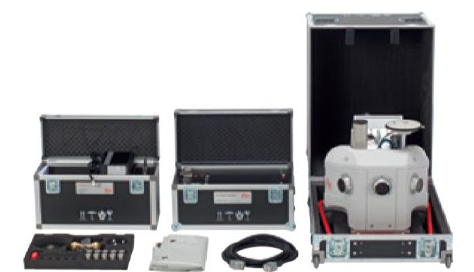
Figure 1. Leica Geosystems Pegasus II